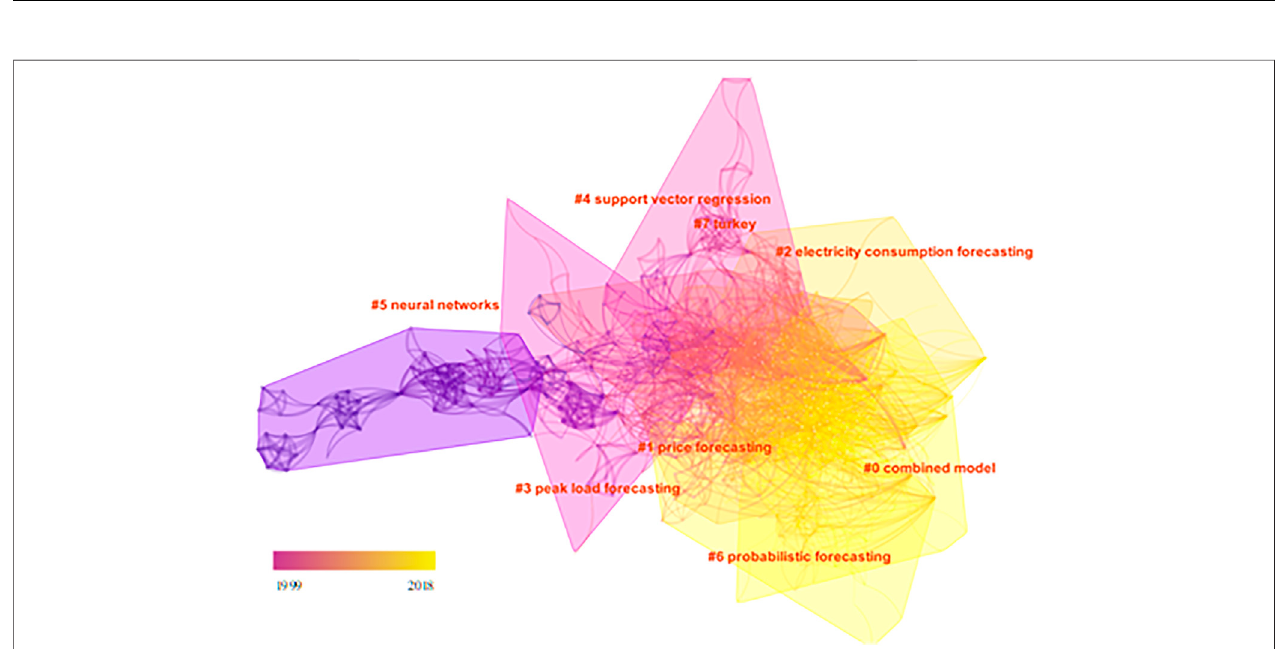
FIGURE 11 | Main co-cited references cluster in electricity demand